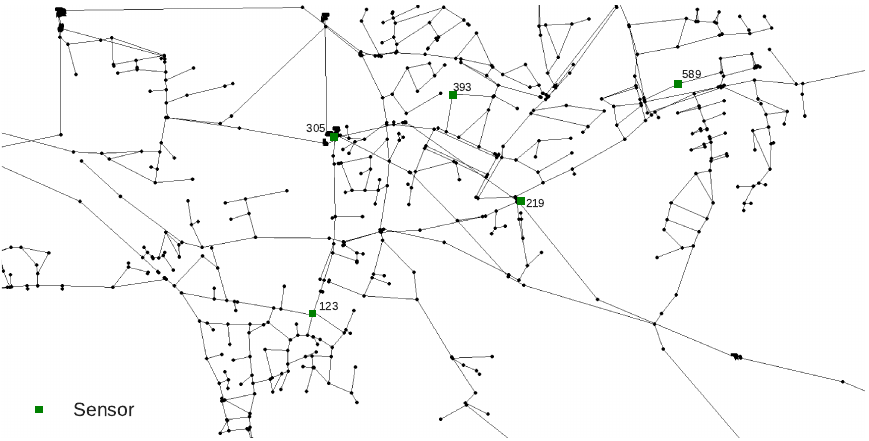
Figure 2. Richmond water supply network layout with sensor positioning by Preis and Ostfeld